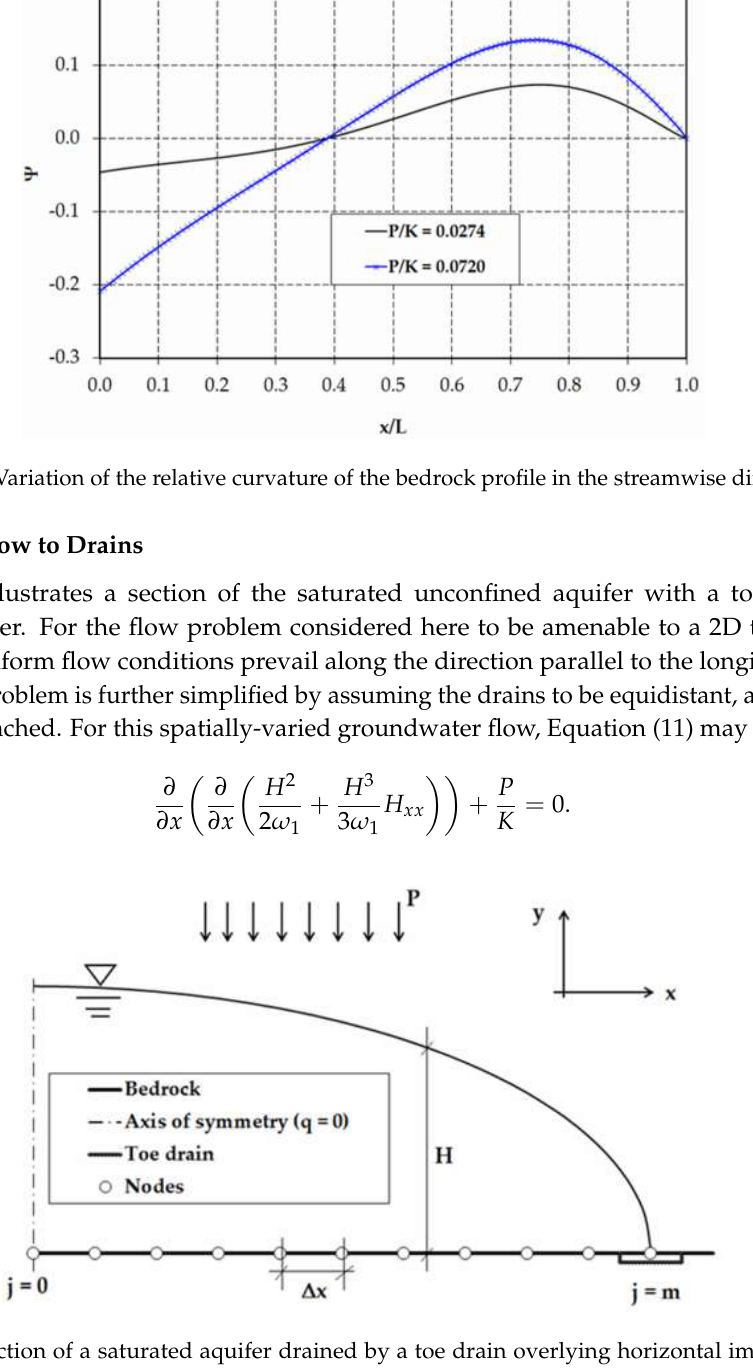
Figure 10. Section of a saturated aquifer drained by a toe drain overlying horizontal impermeable bedrock at the downstream end ( j = m ).